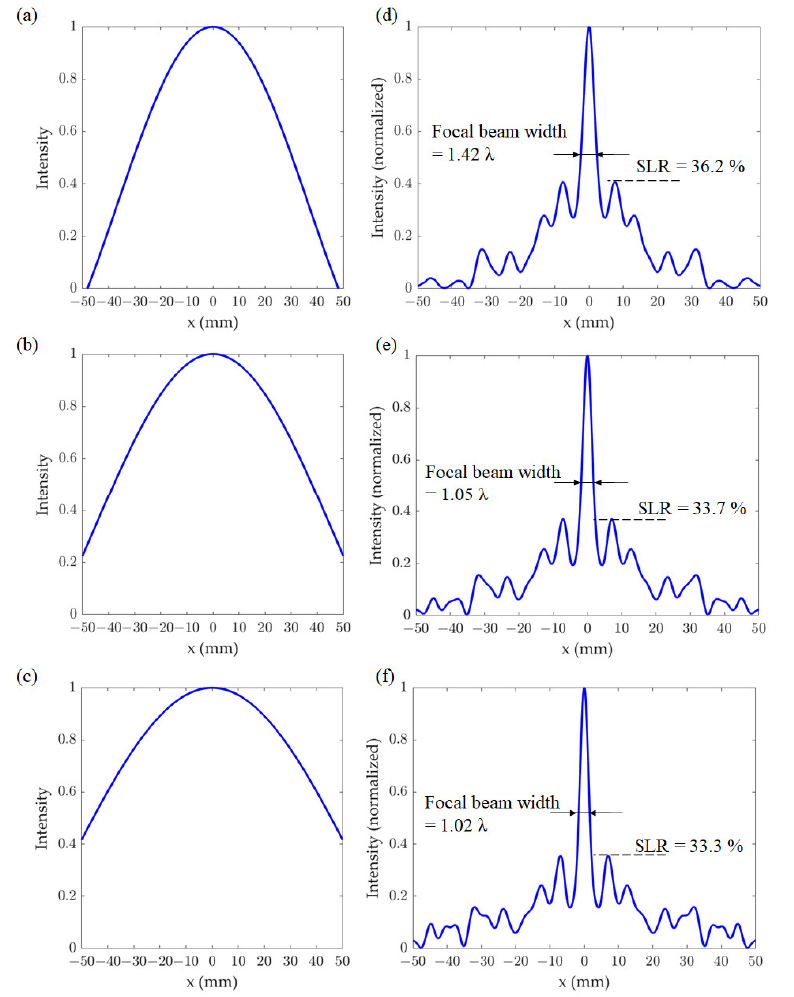
Figure 6. Incident beam profiles and the corresponding focal beam lines generated by the THz-CSOL. ( a – c ) IThe simulated incident beam profiles; and ( d – f ) the calculated intensity profiles along the x direction at the focal length ( z = 70 mm).